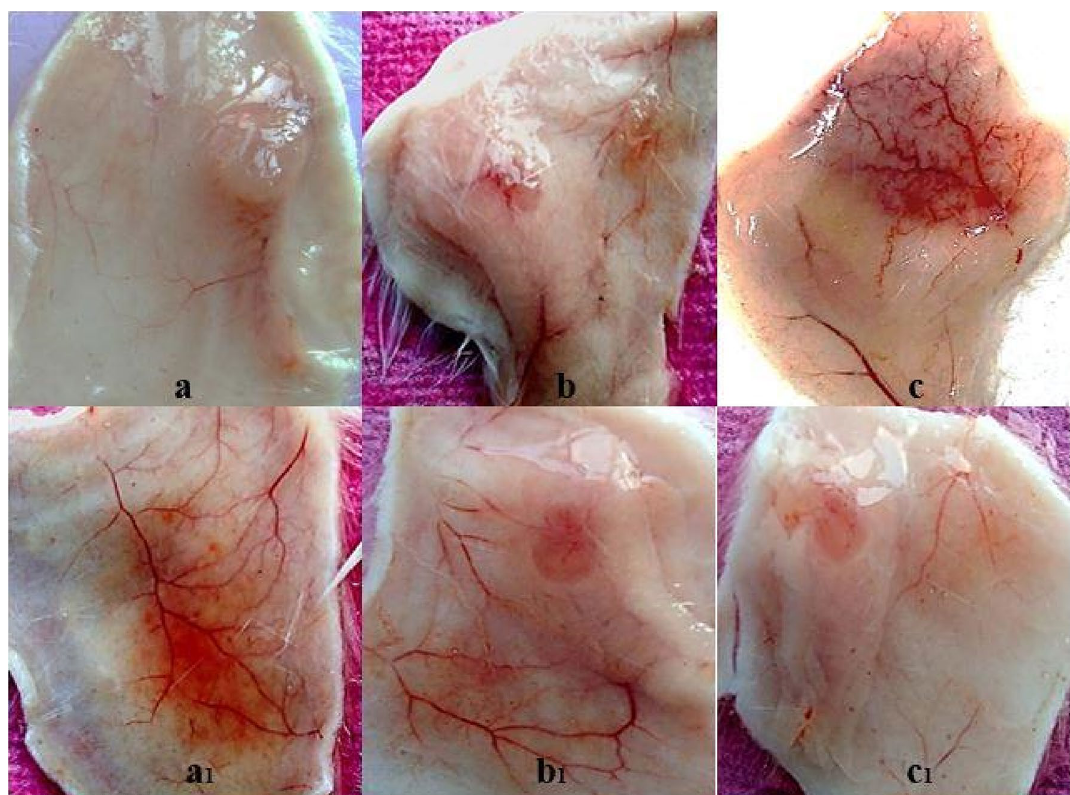
Figure 12. Inhibition of hemorrhagic activity of VR-HC-I by elemolic acid: Mice were intradermally injected the 10 µg of GIIA alone ( a ), 10 µg of non-enzymatic peptide (VNTx-II) alone ( b ), 10 µg of VR-HC-I ( c ); and 5 µM ( a 1 ), 10 µM ( b 1 ), 15 µM ( c 1 ) of elemolic acid was injected after 30 min incubation with 10 µg hemorrhagic complex (VR-HC-I). Mice were sacrificed after 3 h, and hemorrhagic spots on the dorsal surface of the skin were examined and measured using the graph sheet and represented as area (mm 2 ).